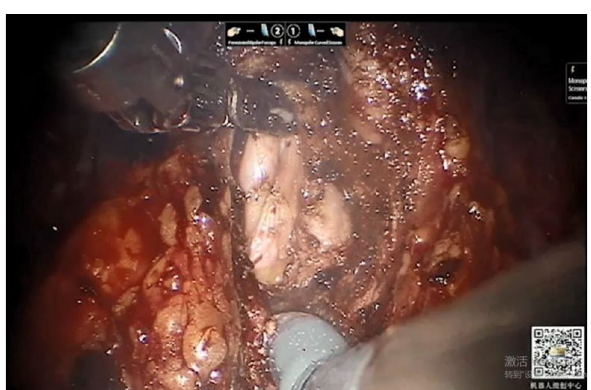
Figure 2. The seminal vesicles were completely exposed after the bilateral vas deferens were